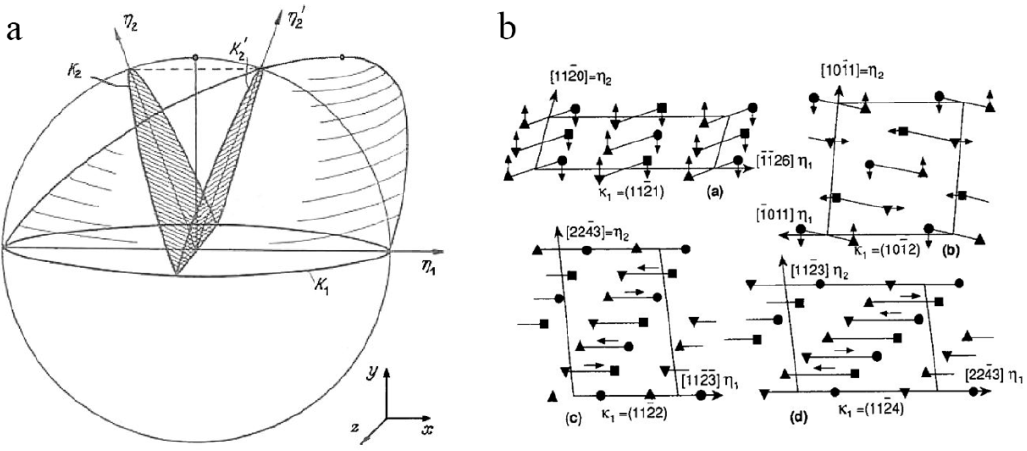
Figure 2. Deformation twinning. ( a ) Lattice deformation and associated (K 1 , η 1 , K 2 , η 2 ) crystallographic parameters, represented by Hall in 1954. Reprinted from [10] with permission from Elsevier. There is no evolution of the fundamental concept in comparison with Mügge’s work published in 1889; ( b ) complex deformation twinning in titanium, involving supercells and shuffles, according to Crocker and Bevis in 1970. Reprinted from [15] with permission from Elsevier.